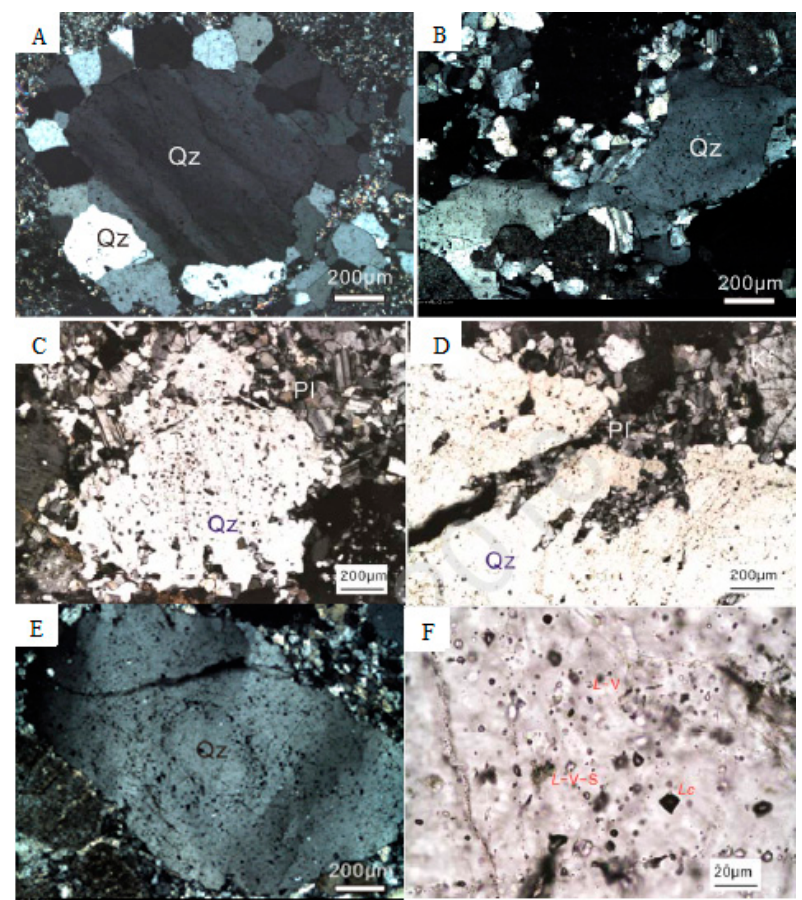
Figure 4. Microscopic features of porphyritic granite and quartz phenocryst in Dongping gold deposit. ( A ) Secondary quartz around the periphery of quartz phenocryst in the strong alteration rocks (sericite ‐ quartz alteration); ( B ) directional distribution of lenticular porphyritic quartz in the fragmented porphyritic granite; ( C ) porphyritic quartz, with its edges surrounded by tiny plagioclase (Pl), containing oligoclase, ZK301A, 283.5 m; ( D ) quartz phenocryst in the porphyritic granite, containing tiny oligoclase aggregates within the fissures, Zhuanzhilian ZK301A, 283.5 m; ( E ) tiny feldspar crystals and fluid inclusions along the growth zone of porphyritic quartz; ( F ) inclusions in the quartz phenocryst containing liquid ‐ vapor two ‐ phase aqueous inclusions and, CO 2 -H 2 O inclusions.